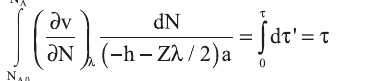
= 20; and b) N = 30. Grains with initially larger number of faces reach much higher volumes before they 0 0